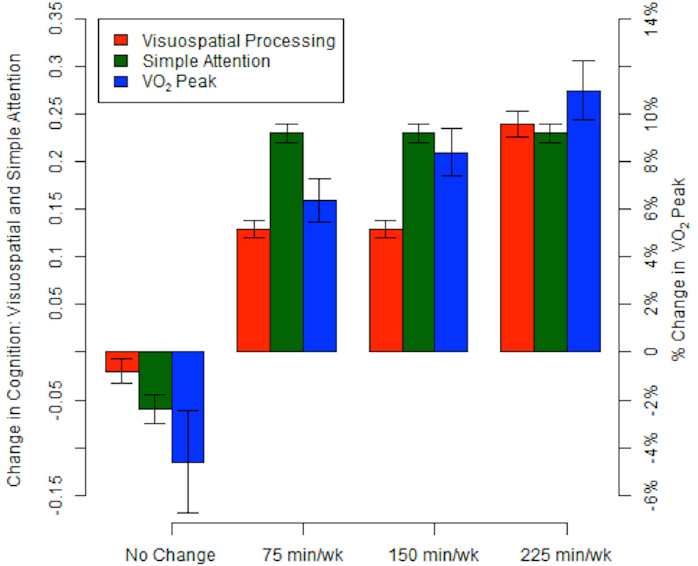
Fig 2. Visuospatial processing but not attention increases with increasing aerobic exercise dose. Percent change in VO 2 peak (blue bars) increases in a dose-response fashion across the PP exercise groups. The best fitting model of Visuospatial Processing (red bars) follows a similar dose-response pattern. The best fitting model of Simple Attention (green bars) shows that any exercise results in improvement.